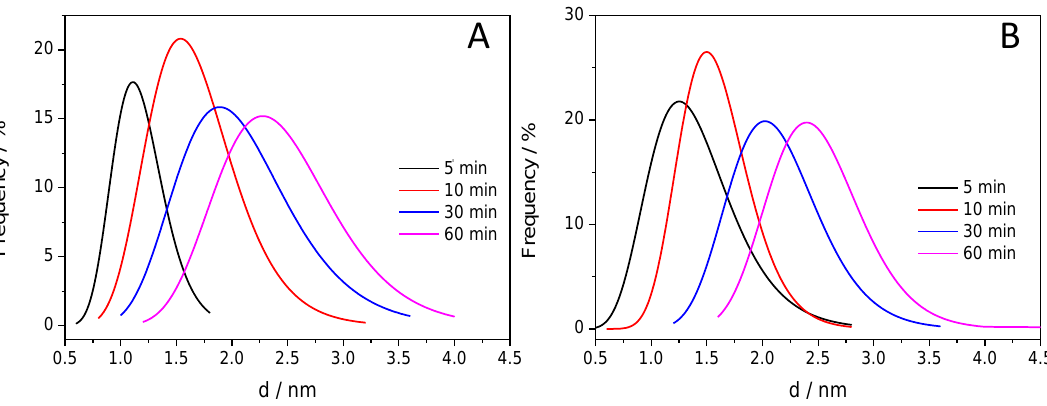
Figure 7. Distribution of the PANI layer thickness for the various SiC/PANI hybrids: ( A ) UV-irradiated samples; ( B ) UV-filtered samples.